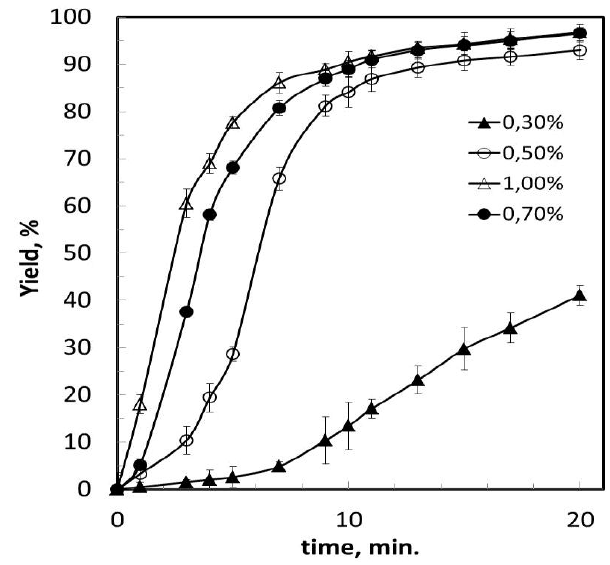
Figure 5. Effect of catalyst concentration on conversion (MeOH:Oil 9:1, 100% ultrasound power).